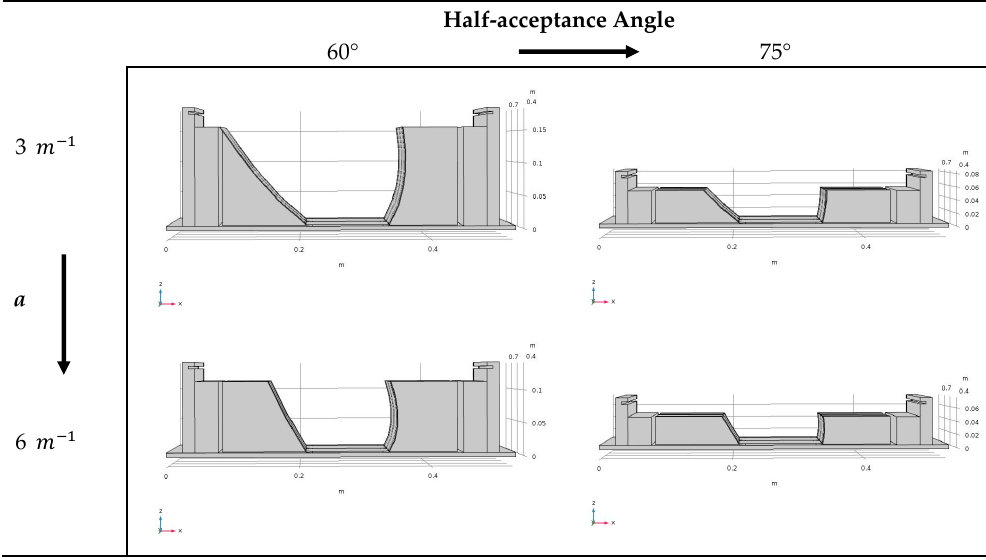
Figure 11. Influence of half-acceptance angle and parabola coefficient on geometry.